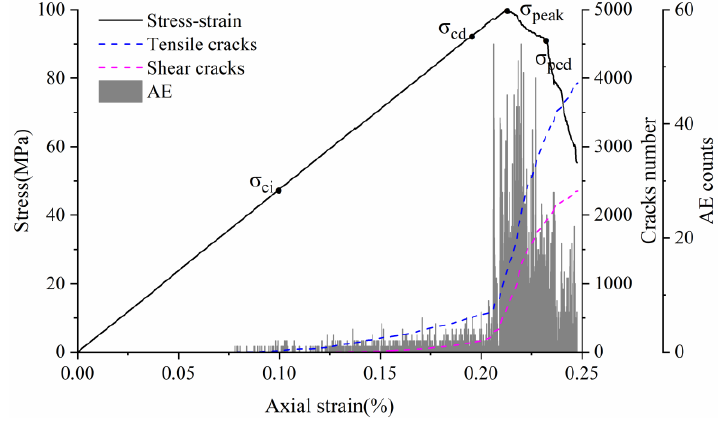
( b ) 20 MPa Figure 9. Comparison of the failure mode between the laboratory tests and the simulated ones. ( a ) 0 MPa. ( b ) 20 MPa. 4. Results and Discussion 4.1. Stress–Strain Curve and Crack Threshold Analysis Eberhardt et al. [5] performed a series of unconfined compression tests on brittle rocks and found that two main thresholds exist before peak strength is reached: (1) crack initiation stress threshold (σ ci ) is determined by the first appearance of the crack and the beginning of the stable extension of the crack; (2) crack damage stress threshold (σ cd ) is determined by the unstable development of cracks, mainly in the form of a sharp increase in the number of cracks starting or a reversal of the volume strain change. Both thresholds are identified by acoustic emission and strain monitoring. There is a gap between the nu- merical simulation method and acoustic emission detection in reality. However, acoustic emission characteristics can be approximated by detecting the stress state of joints and judging and recording the crack generation. This acoustic emission simulation method has been well used in previous studies [49,55,56]. Because the UDEC-GBM model can ef-